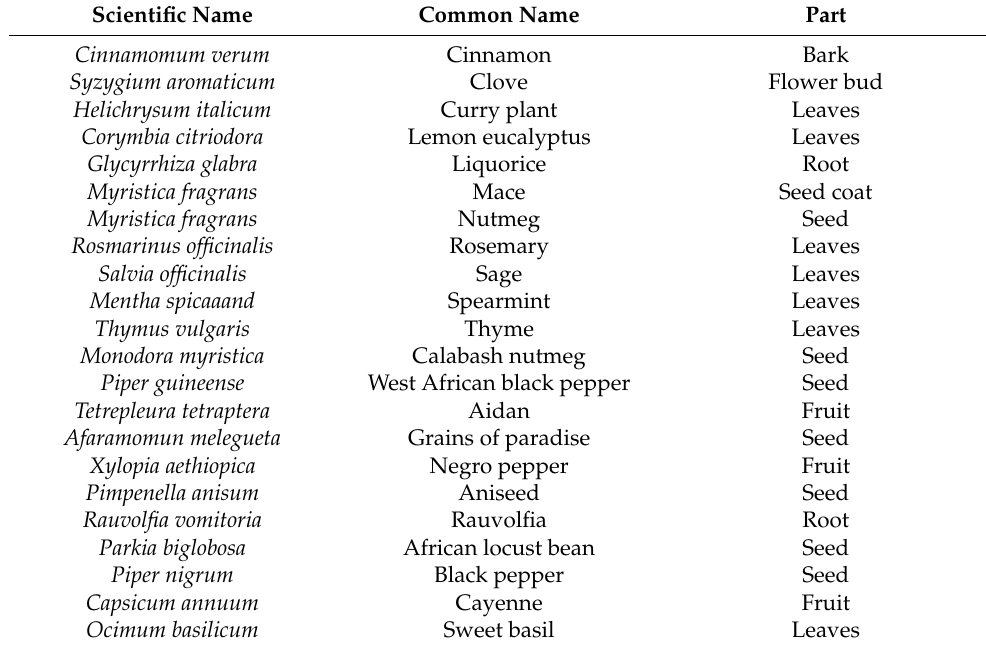
Table 1. Plants tested in this